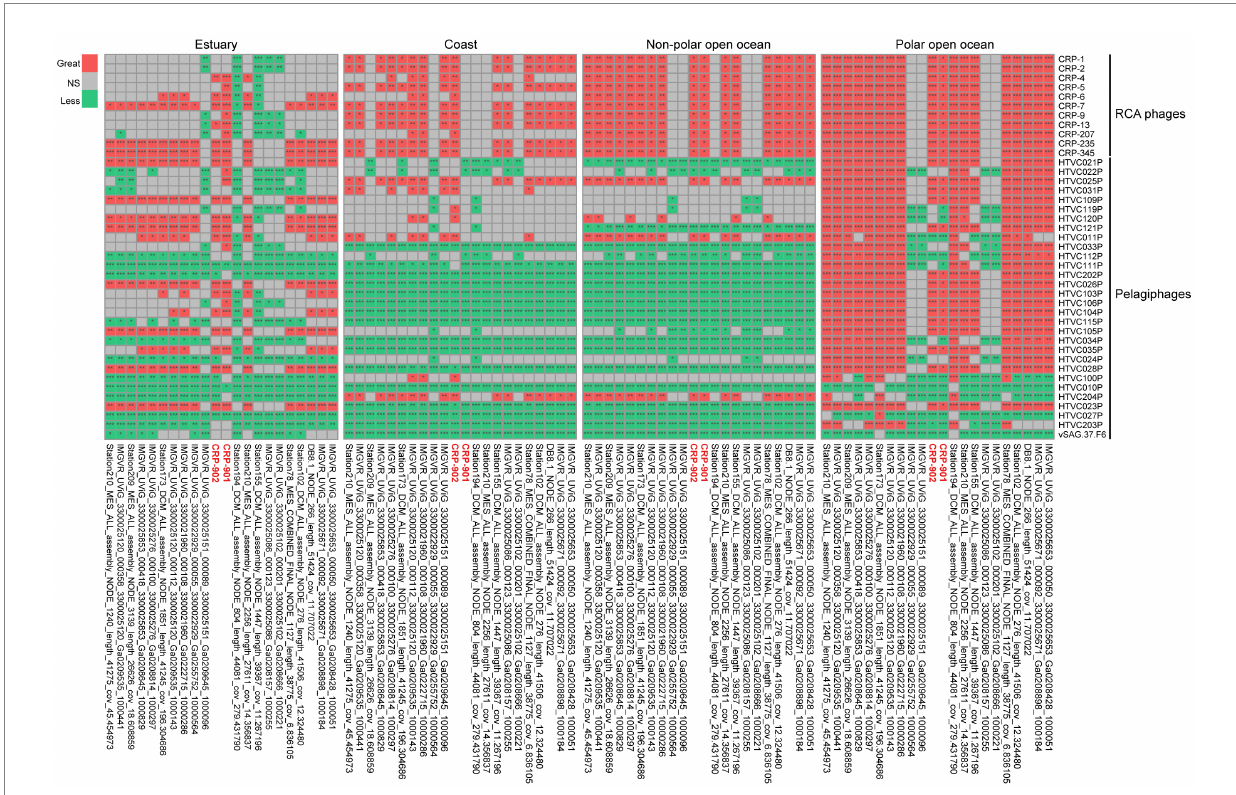
FIGURE 5 Comparative heatmap of the relative abundance of phages CRP-901-type phages with that of known SAR11 and RCA phages in different marine environments calculated with the two-tailed Mann–Whitney U test. Red, green, and gray indicate significantly greater, significantly less, and not significant, respectively. The significance of pairwise comparisons is indicated using an asterisk corresponding to the p -value (* p -value <0.05, ** p -value <0.01, *** p -value <0.001). CRP-901 and CRP-902 are labeled in